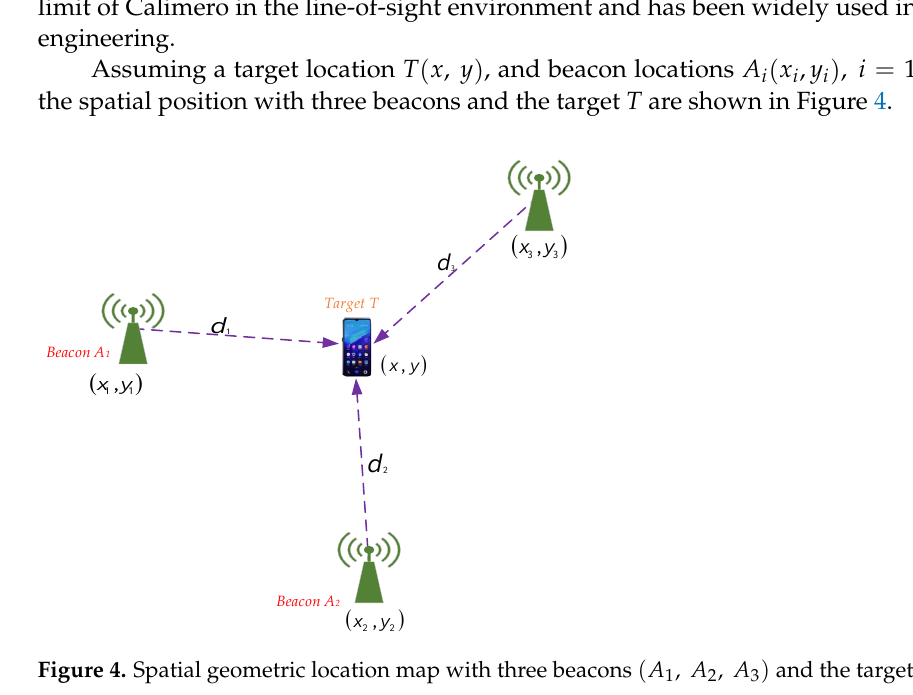
Figure 3. Time domain, frequency domain, and time − frequency characteristic of chirp signal with time duration of 40 ms between 17.5 and 19.5 kHz.